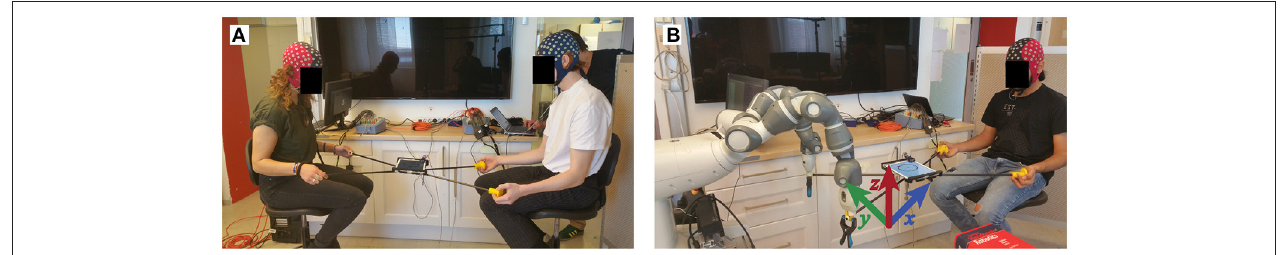
FIGURE 2 | Experimental setup. Participants performed the experiment with another participant (A) or a robot partner (B) . In each condition they played a tablet game by balancing a virtual ball on a circular track while moving it in the counter-clockwise direction.